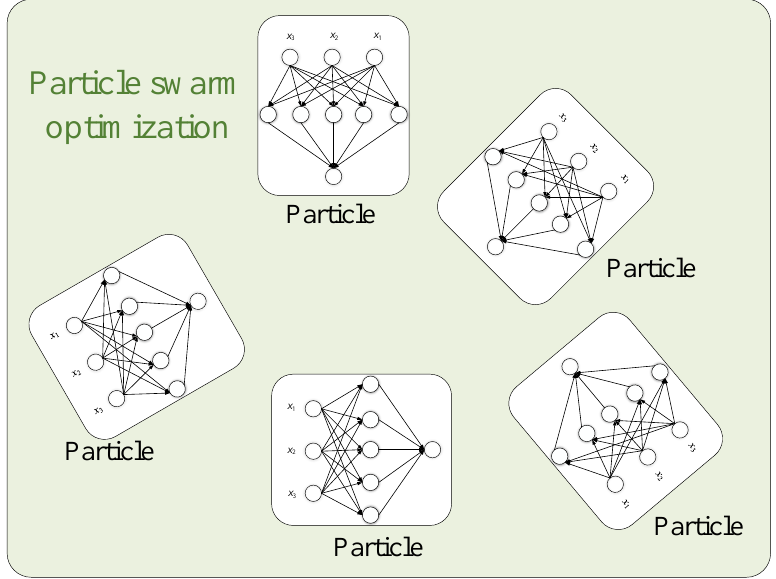
Figure 7. Feed forward neural network trained with